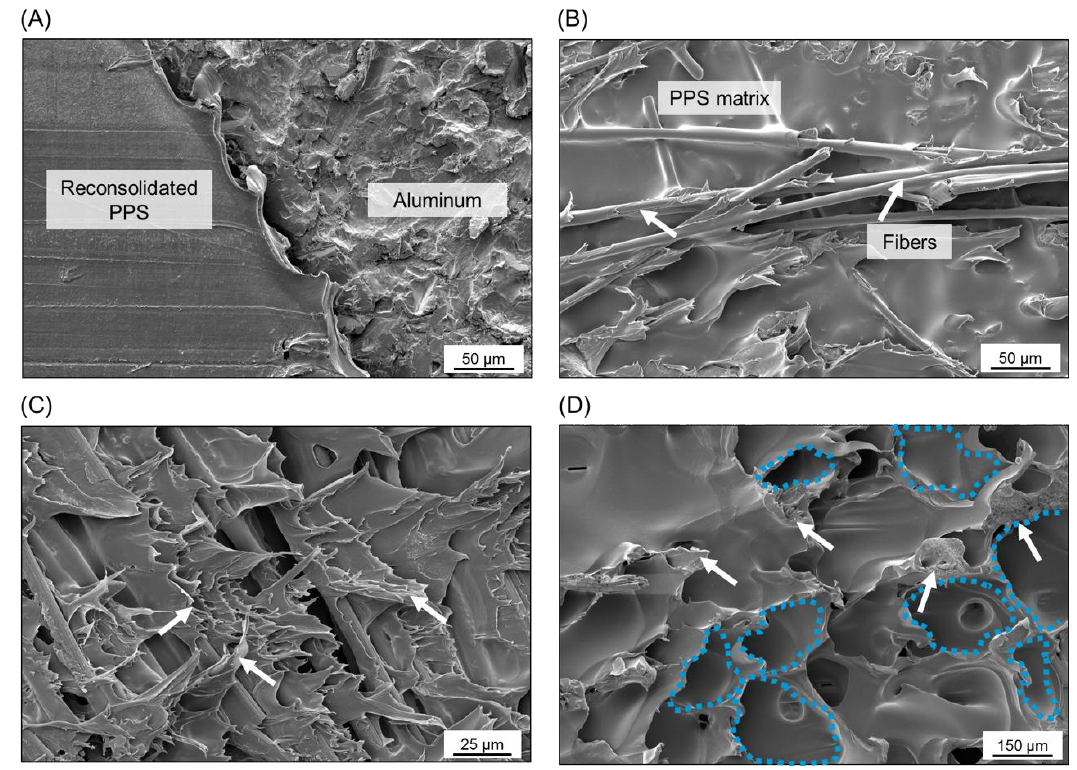
Figure 13. Detailed SEM images of the bonding zones in a representative AA7075-T6/CF-PPS friction spot joint. ( A ) The transition between AZ and TZ. ( B ) The PDZ on the aluminum surface. ( C ) The PDZ and ( D ) the TZ on the composite surface.